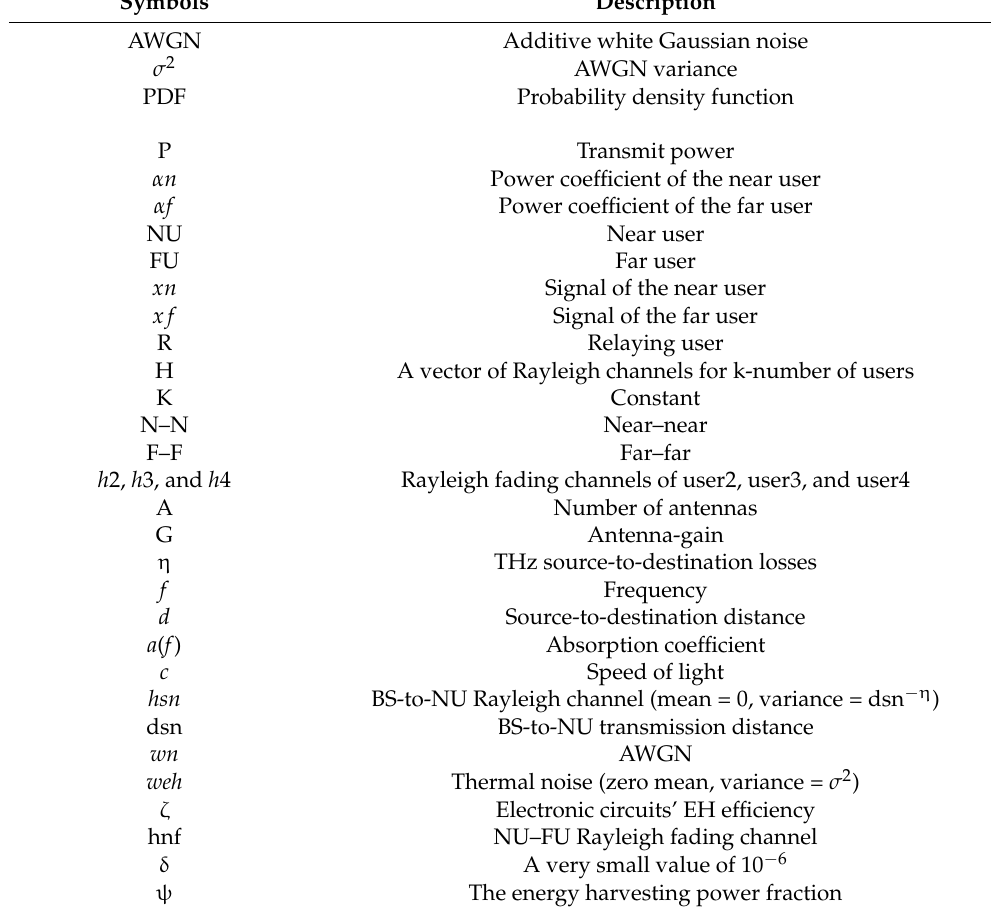
Figure 2. Main system model. Table 1. Mathematical equation symbols .